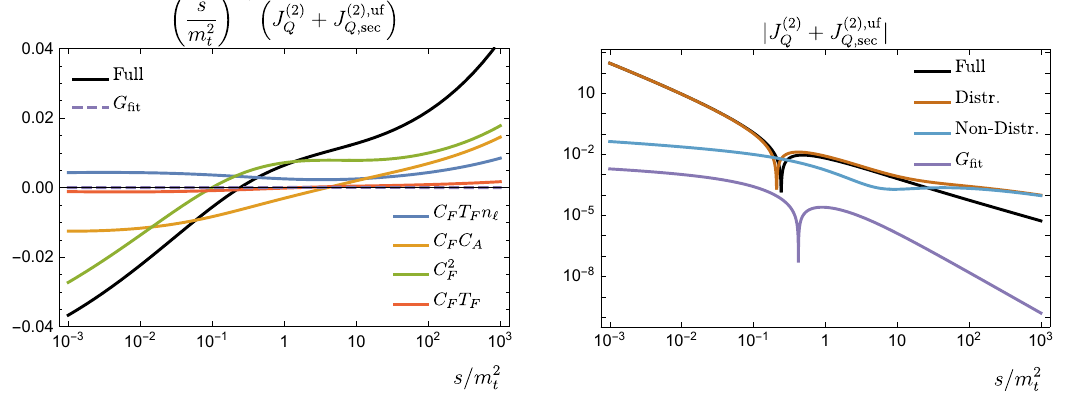
Figure 7 . Left: Size of contributions to the O ( (cid:11) 2 ) coe(cid:14)cient of the universal SCET massive s p primary quark jet function from di(cid:11)erent color structures as a function of s=m 2 for (cid:22) = s +5 GeV, t n ‘ = 5 and m = m t = 173 GeV multiplied by ( s=m 2 ) 1 : 3 . Right: Double logarithmic plot of the t modulus of the full O ( (cid:11) 2 ) corrections and the corresponding contribution coming from G (cid:12)t . We s also show the sum of all distributional O ( (cid:11) 2 ) corrections and the non-distributional s